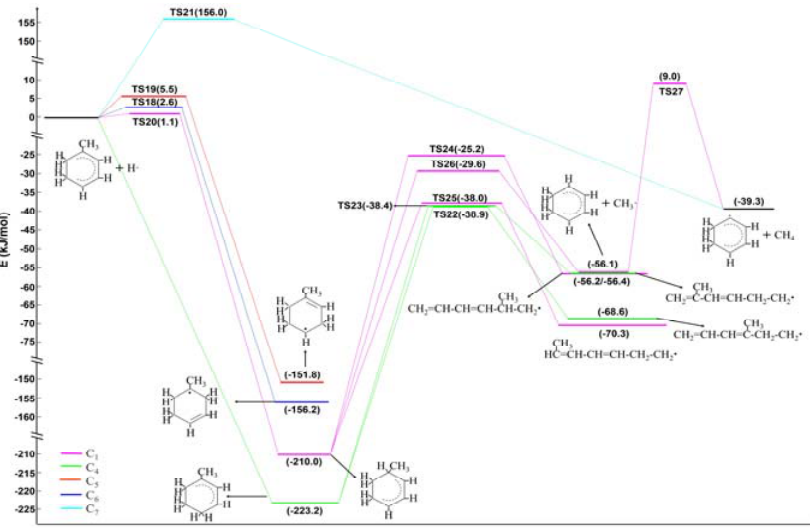
Figure 4. Energy profiles of hydrogenation and hydrocracking by the third H atom for second- generation hydrogenated products.